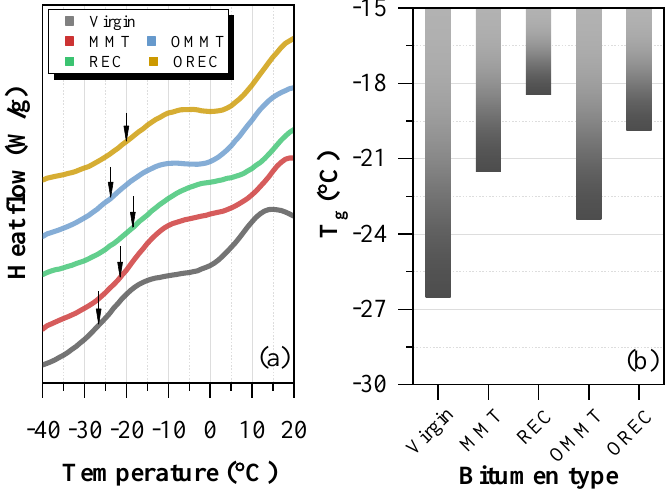
Figure 10. The differential scanning calorimetry (DSC) test result for bitumen specimens: ( a ) Determination of T g ; ( b ) T g result.